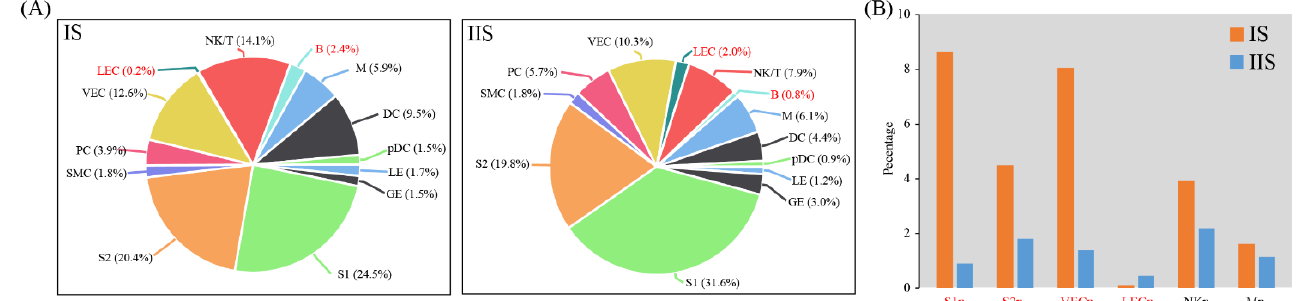
Figure 2. Cell population shifts in implantation sites compared to inter-implantation sites: ( A ) Pie plots showing the cell population change of 13 major cell types in implantation sites (IS) compared to inter-implantation sites (IIS) on gestational day 5. For each cell type, proliferating and non-proliferating cells were summed; ( B ) Bar plot showing cell population changes of proliferating cells. Cell types with fold change (based on percentage) > 2 and p -value ( χ 2 test) < 0.05 were labeled in red.